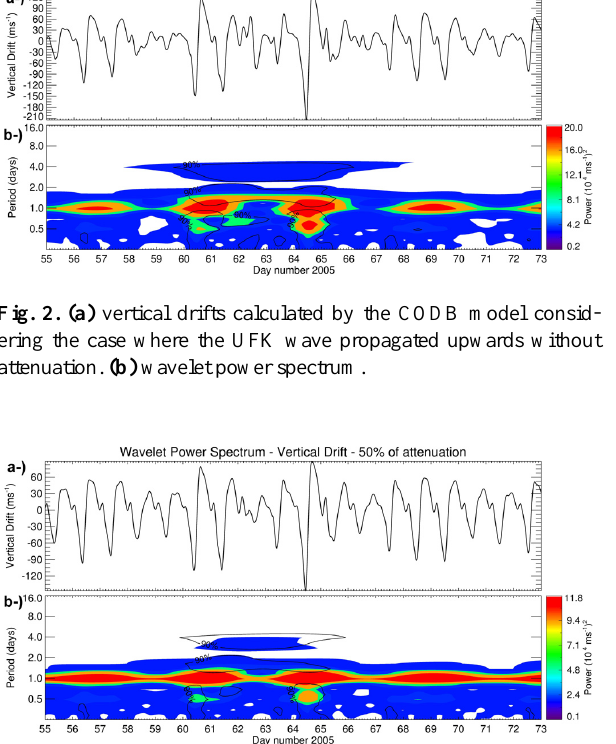
Fig. 3. (a) vertical drift calculated for the case where the UFK wave propagated upwards with 50% attenuation. (b) wavelet power spec-